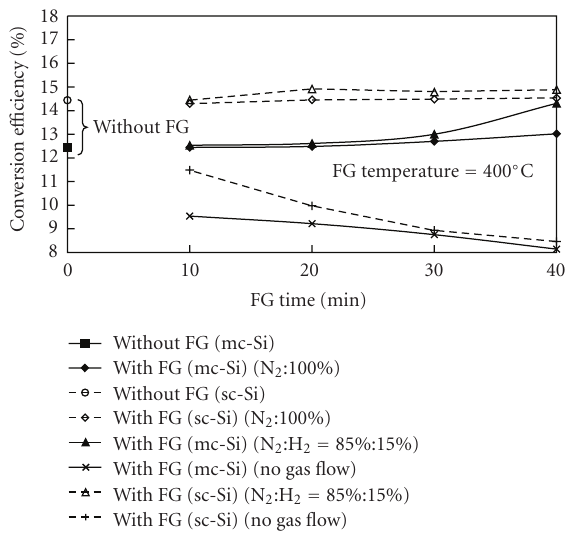
Figure 4: The open-circuit voltages ( V OC ) and the short-circuit currents ( I SC ) of sc- and mc-Si solar cells without ( t = 0 min) and with di ff erent H 2 FG treatment time.